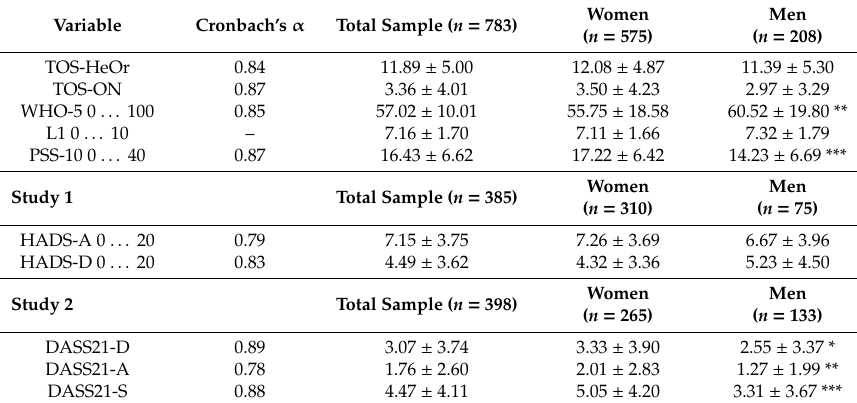
Table 2. Descriptives of the study